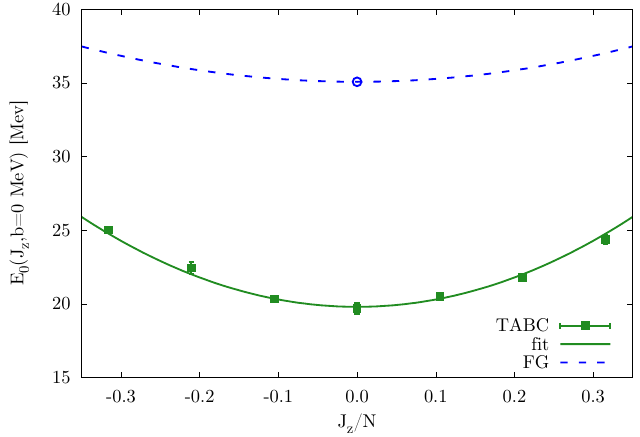
Figure 2. PNM energy per particle E 0 ( J z , b ) at saturation density with seven different values of J z / N with no external magnetic field. Green squares with error bars indicate the AFDMC results with Monte Carlo statistical uncertainties while using TABC. The system is realized by 38 neutrons interacting via the AV8 (cid:48) + UIX potential, and five TABC are considered. The solid green line is a quadratic fit to the AFDMC results. The blue dashed curve shows the analytic solution of the free FG, with the ground-state polarization highlighted with a blue empty circle.